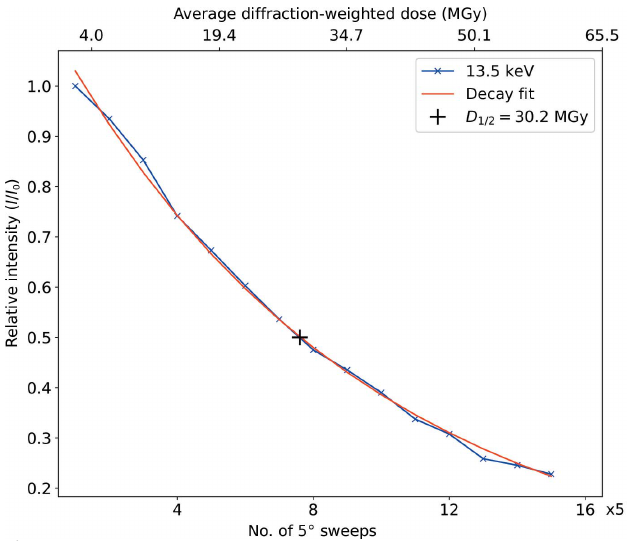
Figure 2 Determination of D 1/2 based on the fitted decay curve of the normalized